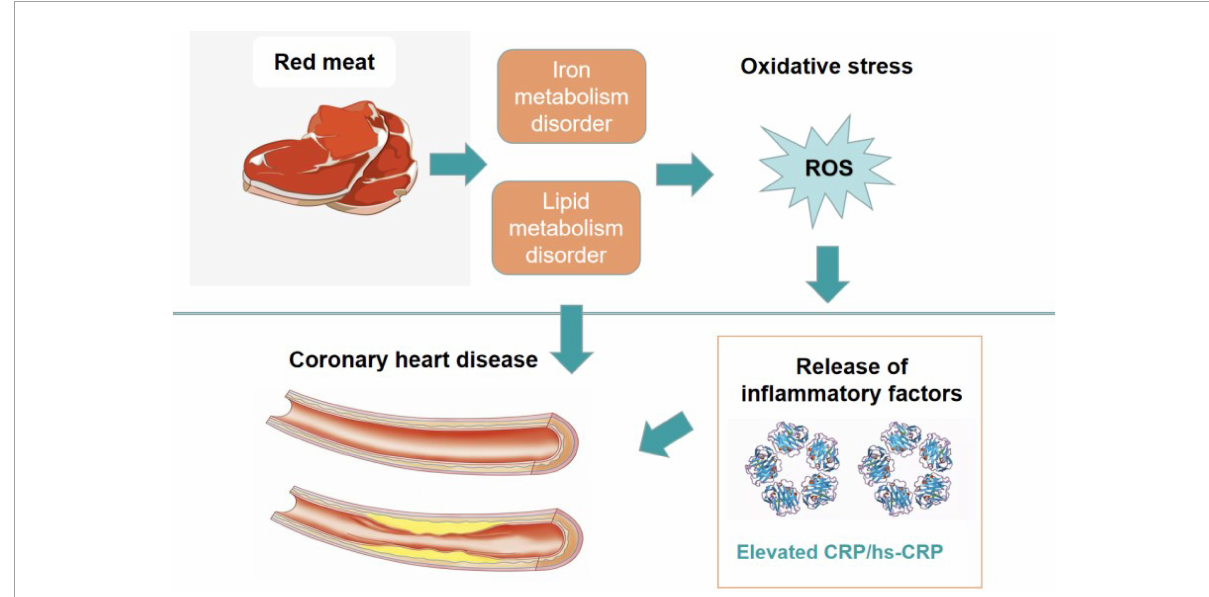
FIGURE1 Mechanism of lipid metabolism and inflammatory reaction induced by red meat.